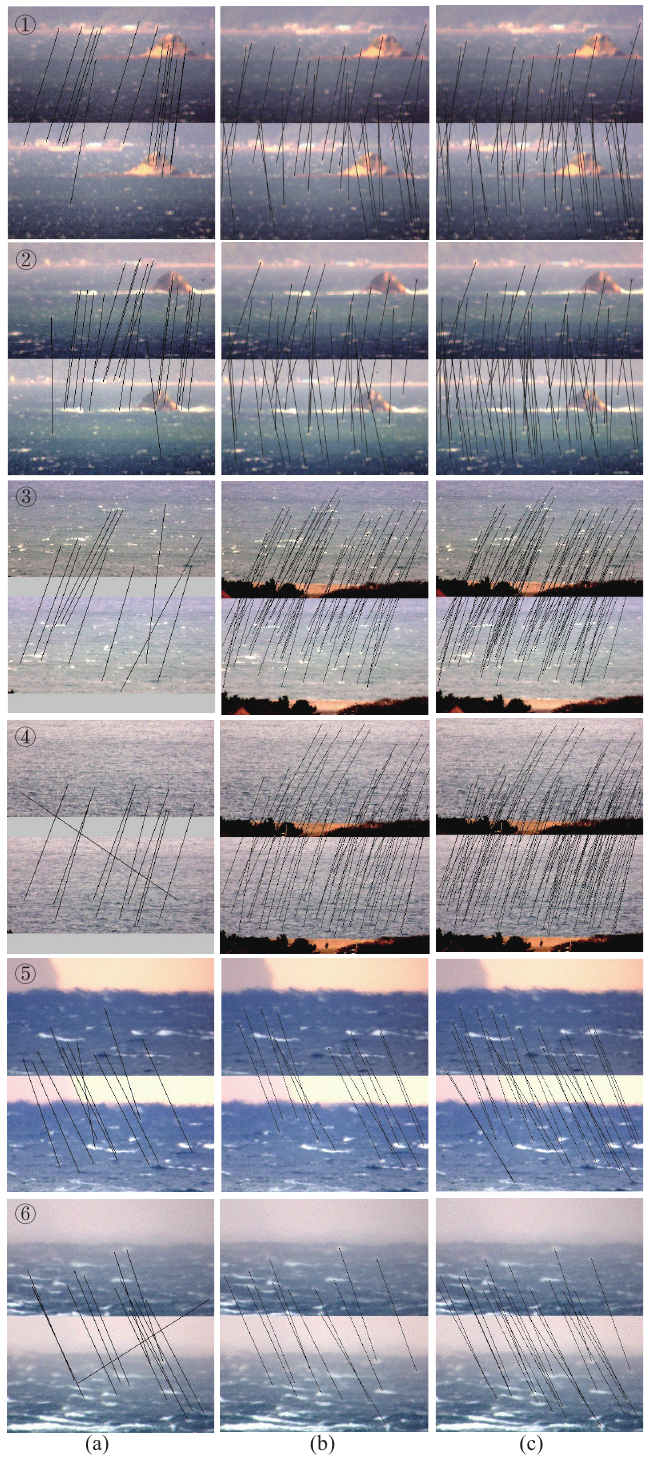
Figure 12. Comparisonof RANSAC+SURF, Euclidean distance and the proposed method:Rows 1 (cid:13) and 2 (cid:13) are the images taken at 18–23 August 2018 (8–14 km); Rows 3 (cid:13) and 4 (cid:13) are the images taken at 8–15 March 2017 (4–10 km); Rows 5 (cid:13) and 6 (cid:13) are the images taken at 29 February–6 March 2016 (14–20 km). Column ( a ) shows the results of RANSAC+SURF; Column ( b ) shows the results of Euclidean distance; and column ( c ) shows the results of the proposed